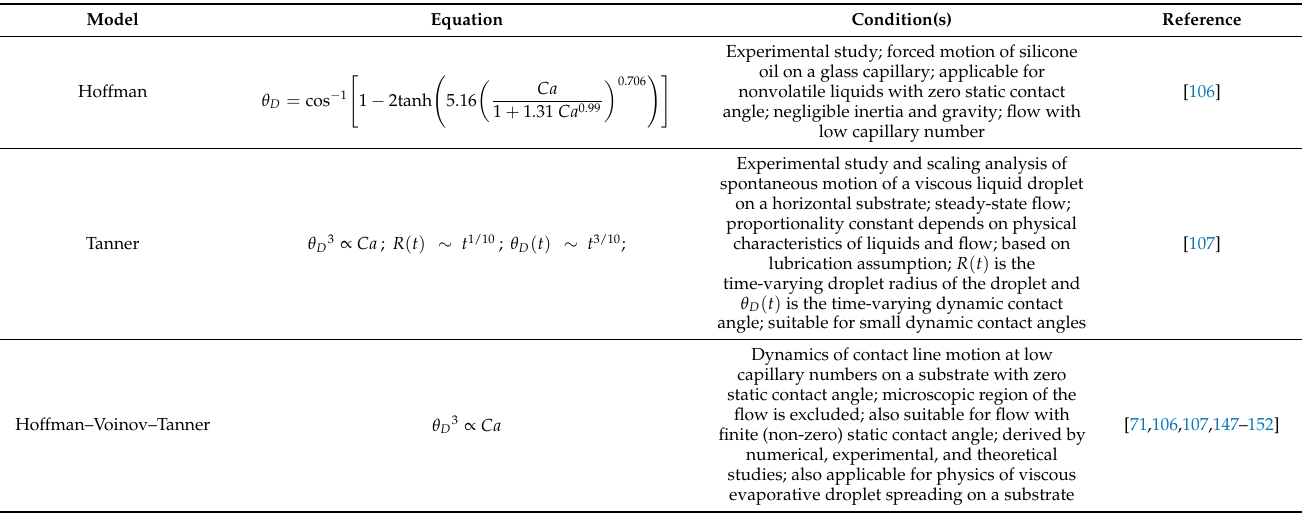
Experimental study; forced motion of silicone oil on a glass capillary; applicable for nonvolatile liquids with zero static contact angle; negligible inertia and gravity; flow